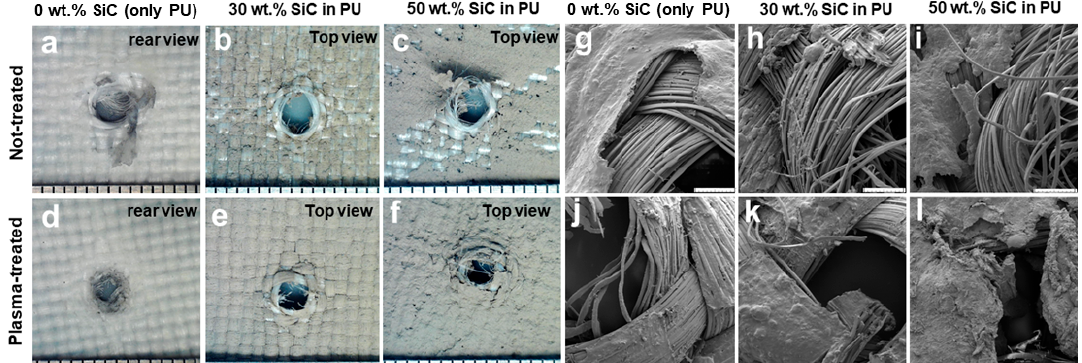
Figure 5. ( a – f ) Top and rear views of plasma-treated and not-treated UHMWPE fabrics coated with different mixtures of SiC in PU after penetration. ( g – l ) SEM images (top view) of plasma-treated and not-treated UHMWPE fabrics coated with different mixtures of SiC in PU. The scale bar is 500 µm.